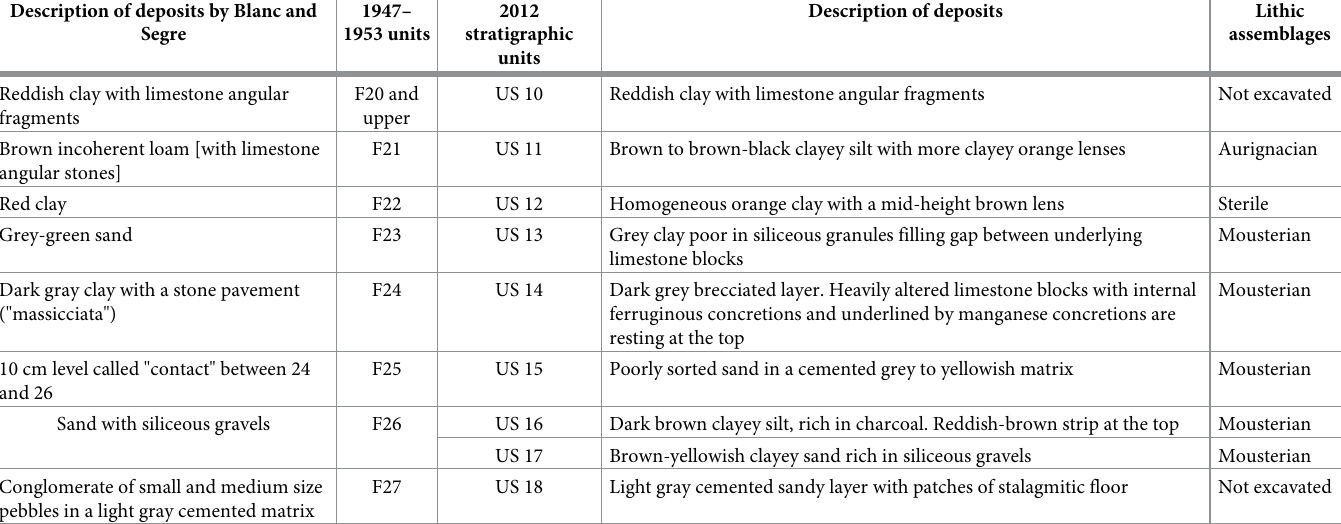
Table 1. Proposal of correlation between the 1947–1953 stratigraphy from [49] and the stratigraphy described for the 2012 section. Description of deposits by Blanc and